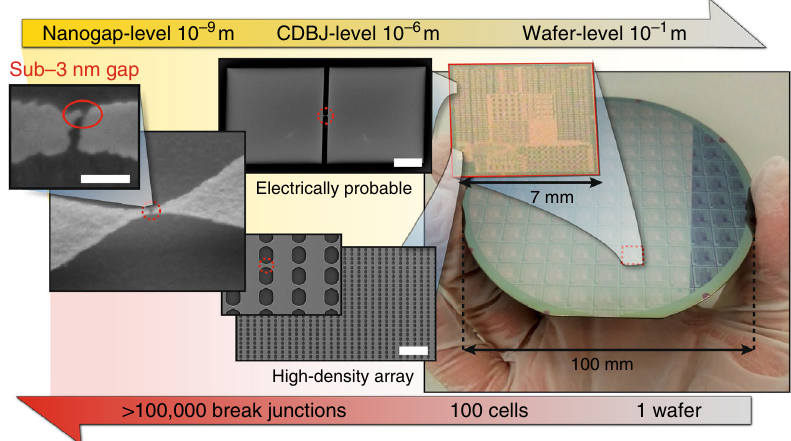
Fig. 2 Hierarchical depiction of the fabrication of crack-de fi ned break junctions on a wafer scale. Optical and SEM images of fabricated crack-de fi ned break junctions (CDBJ) depicted in a range from the nano-scale (sub-3 nm gaps) to the macro-scale (100 mm diameter wafer). A total of 780,000 bridge structures were fabricated and released simultaneously using only conventional wafer-scale processes on the 100 mm diameter wafer. Upon cracking, each bridge subsequently exerted a de fi ned pulling action on the section of gold located above the crack-line, thereby forming hundreds of thousands of CDBJs in a massively parallel fashion on wafer-scale. Scale bar is 30 µ m for the “ electrically probable ” CDBJ, 20 µ m for the “ high-density array ” of CDBJs, and 50 nm for the CDBJ featuring a sub-3 nm